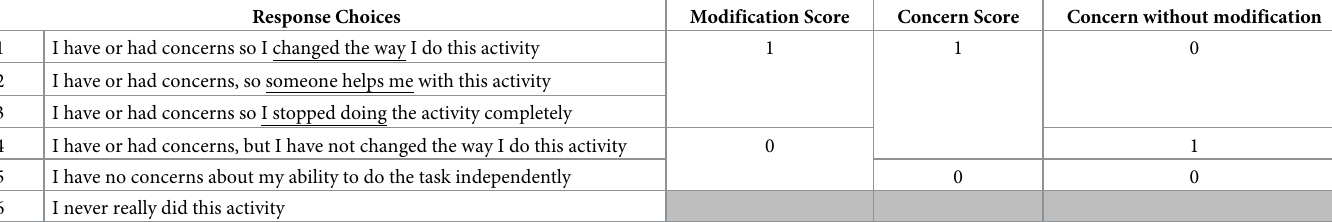
Table 1. Table detailing the response choices and the derived primary outcome scores from the Activity Modification